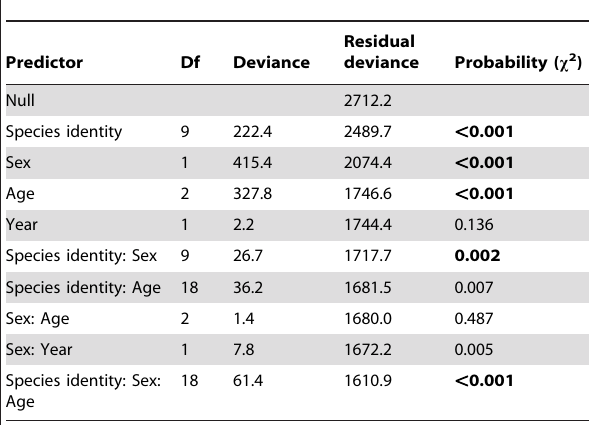
Table 1. Analysis of deviance for expected gregarine abundance in the observational study, according to species identity, sex, age year and their interactions.